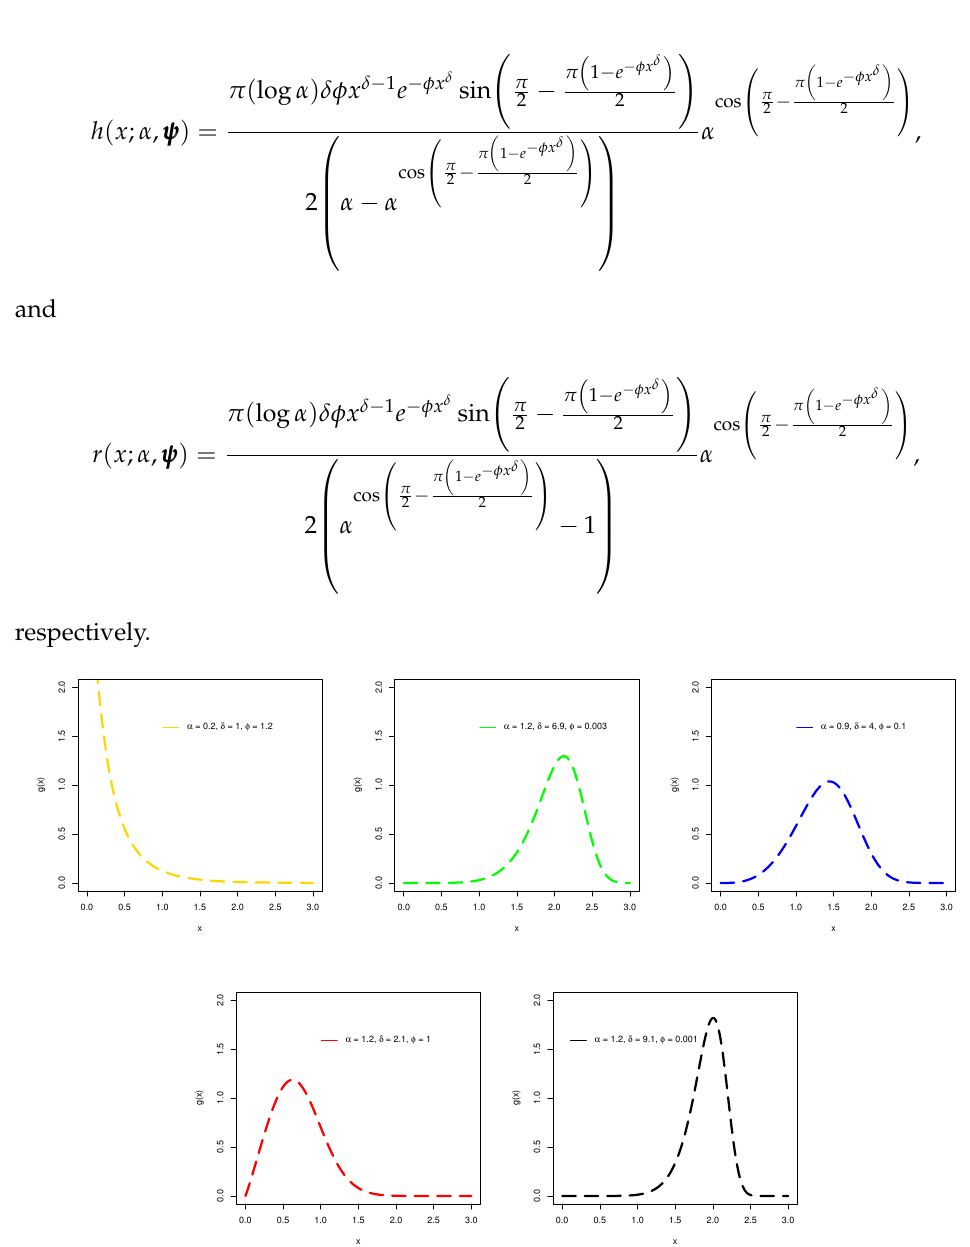
Figure 1. Illustrations of g ( x ; α , ψψψ ) of the NACos-Weibull for different values of α , φ , and δ . Figure 2 offers the visual behavior of the HF h ( x ; α , ψψψ ) of the NACos-Weibull distribu- tion. From Figure 2, it can be seen that h ( x ; α , ψψψ ) of the NACos-Weibull model has different shapes. These shapes include ( i ) unimodal form (golden curve shape), ( ii ) modified uni- modal form (green curve shape), ( iii ) increasing form (blue curve shape), ( iv ) decreasing form (red line shapes), and ( v ) bimodal form (black line